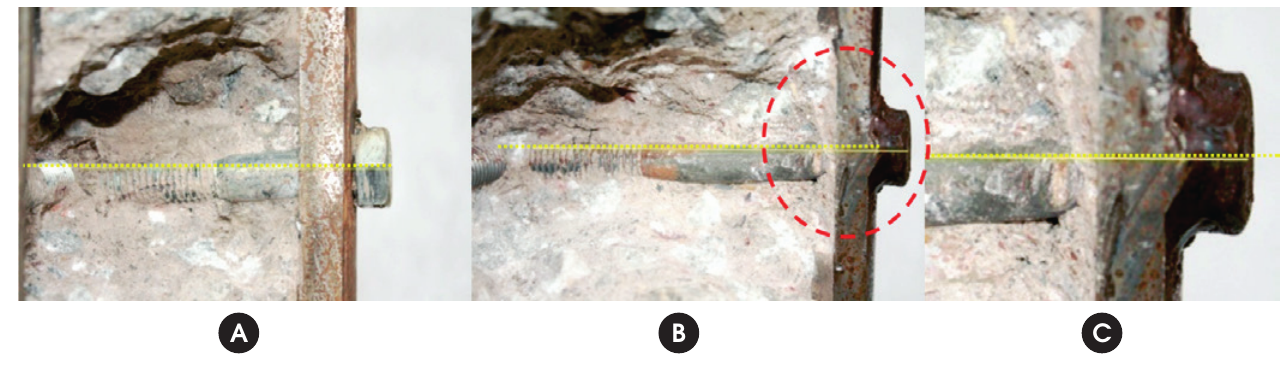
Deformed final configuration of the connectors: (a) Detail of connector of model C2; (b) Detail of connector of model C15; (c) Shear detail on connector of the model C15